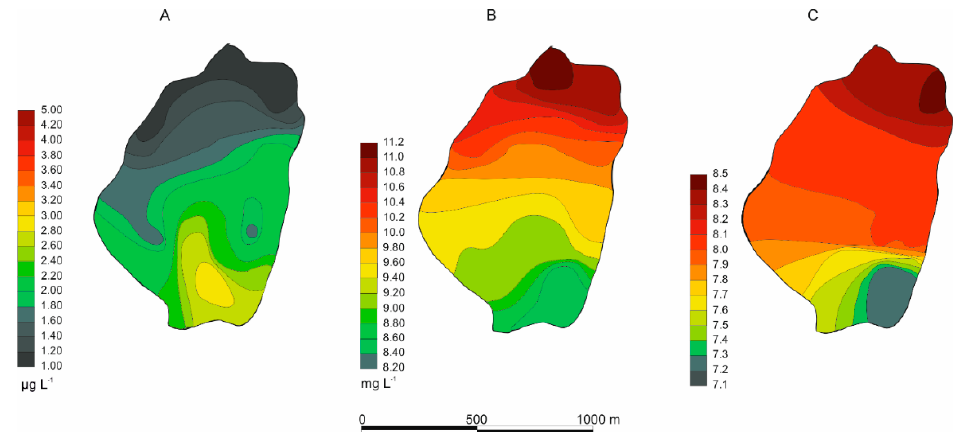
Figure 2. Exemplary maps of the spatial variability of the studied parameters for the surface layer: ( A ) Chl-a; ( B ) dissolved oxygen; and ( C ) pH.